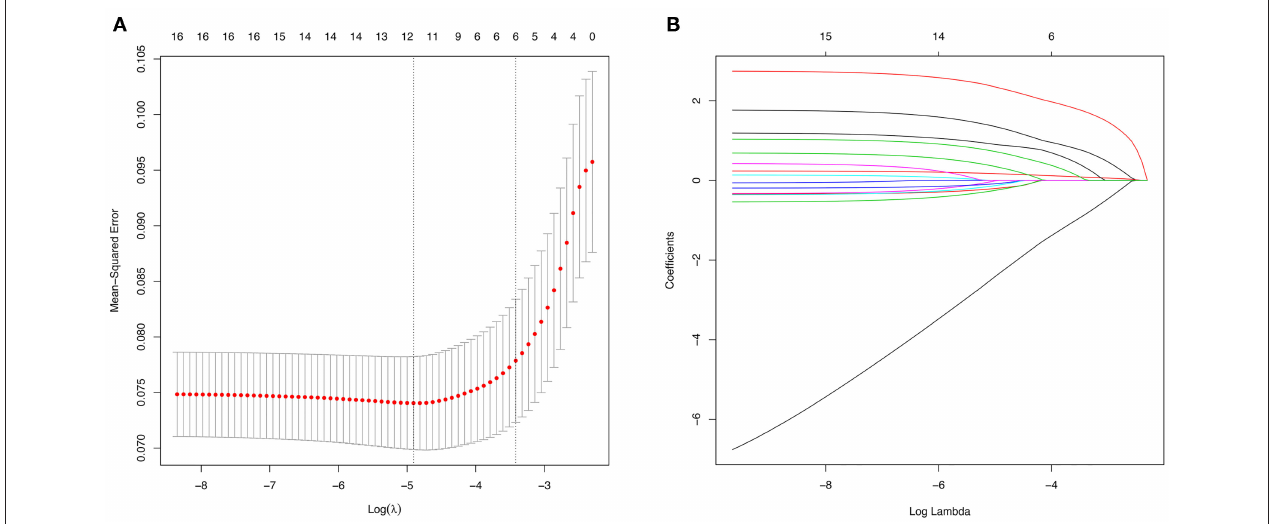
FIGURE 2 | Variable selection using the least absolute shrinkage and selection operator (LASSO) regression model. (A) The selection of optimal predictive variables by 5-fold cross-validation. The left and right dotted vertical lines represent the optimal values of lambda when using the minimum criterion and the one-fold standard error of minimum criterion, respectively. (B) LASSO coefficients of the 15